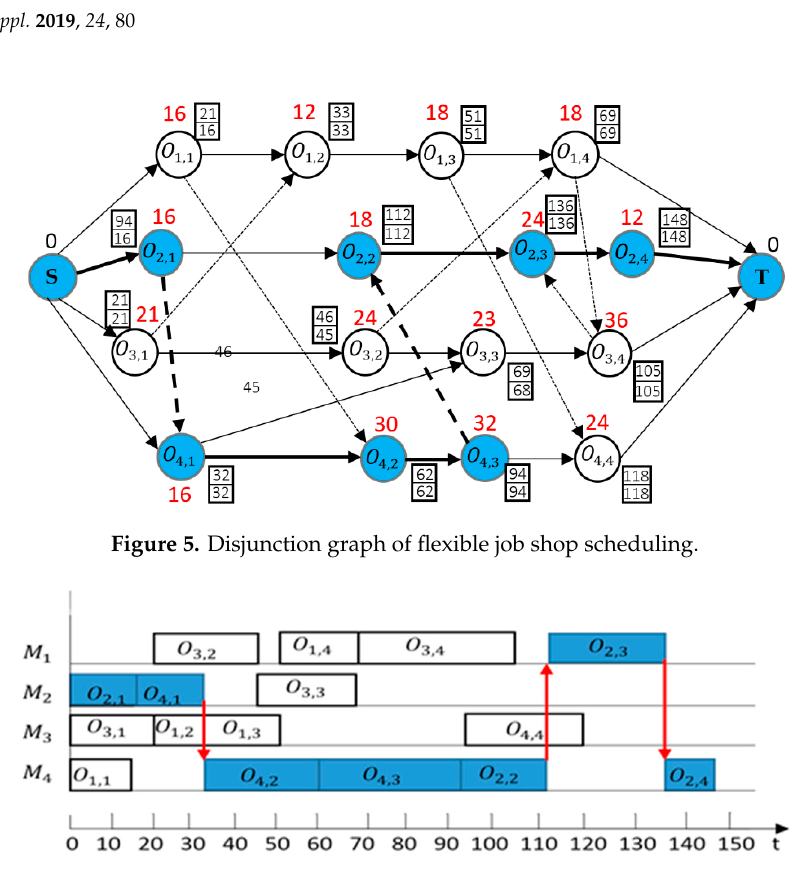
Figure 6. Critical pathway for flexible job shop scheduling.